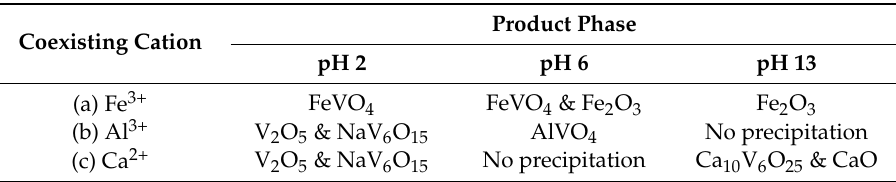
Table 3. Crystallographic phases identified in the precipitates at pH 2, 6, and 13 with combinations